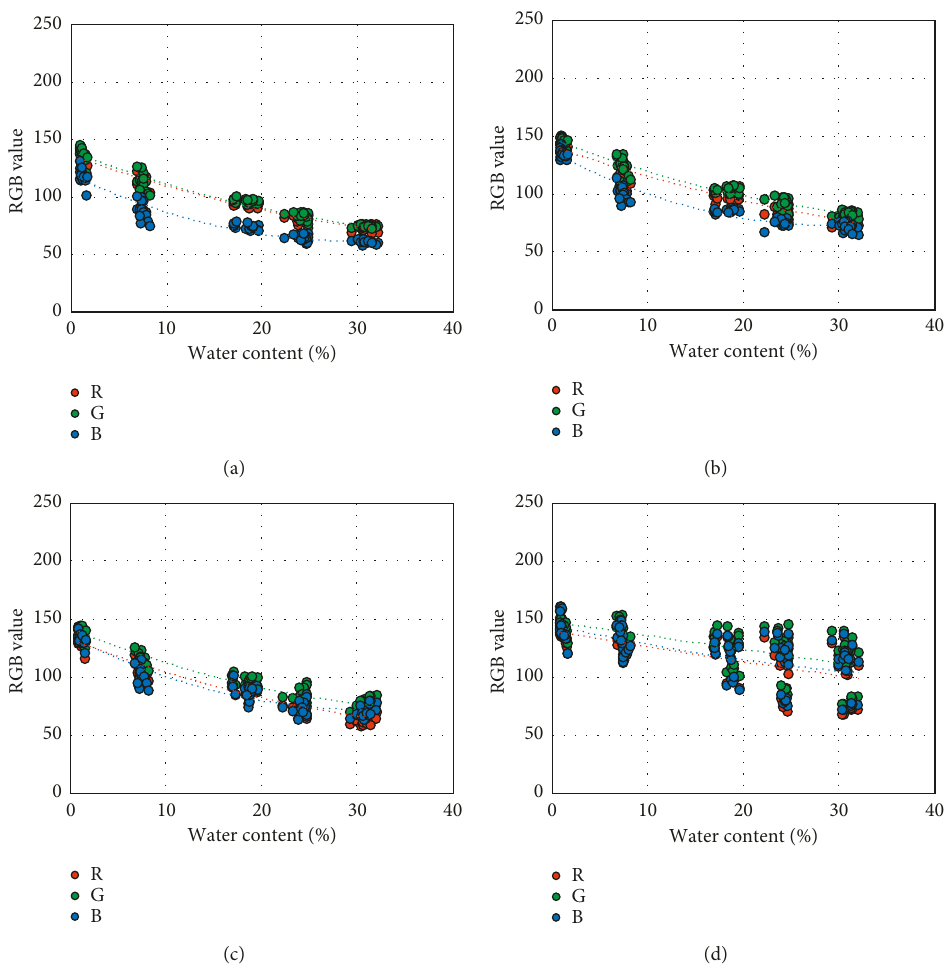
Figure 6: Variation of RGB values according to the water content. Altitude: (a) 20 m; (b) 50 m; (c) 100m; (d)